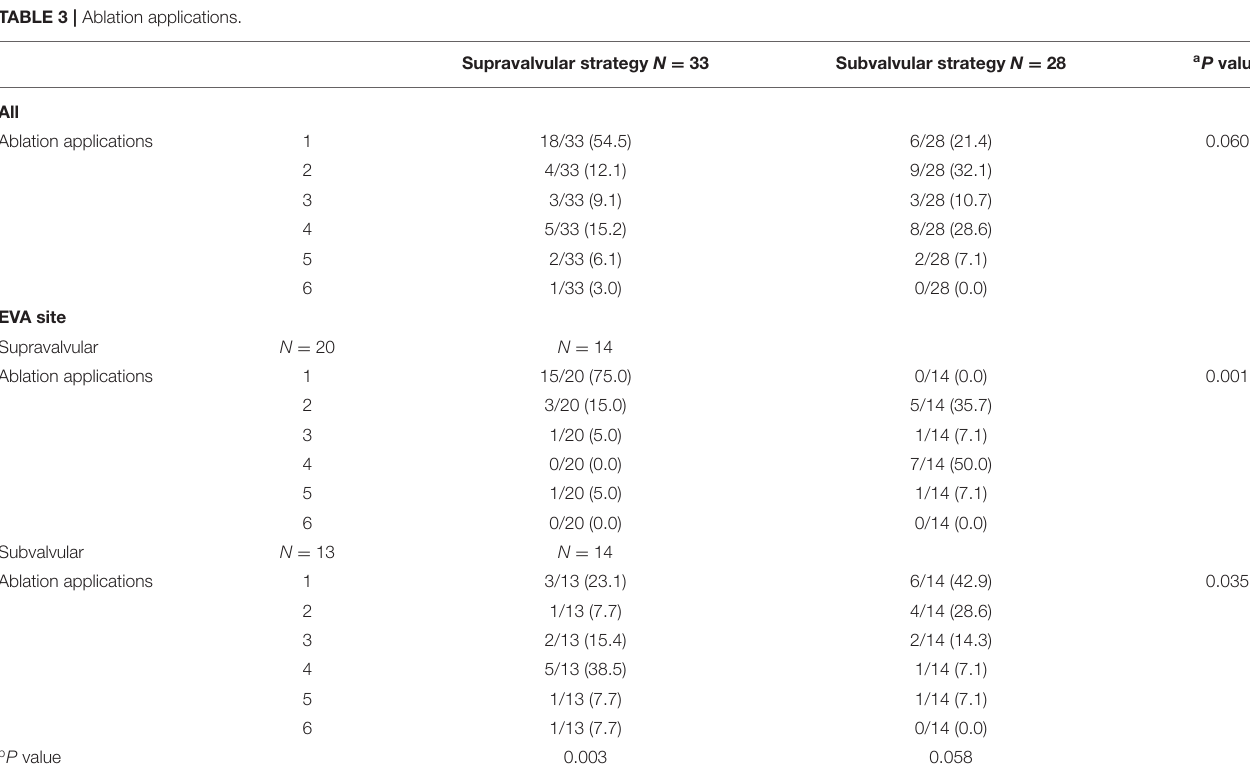
TABLE 3 | Ablation